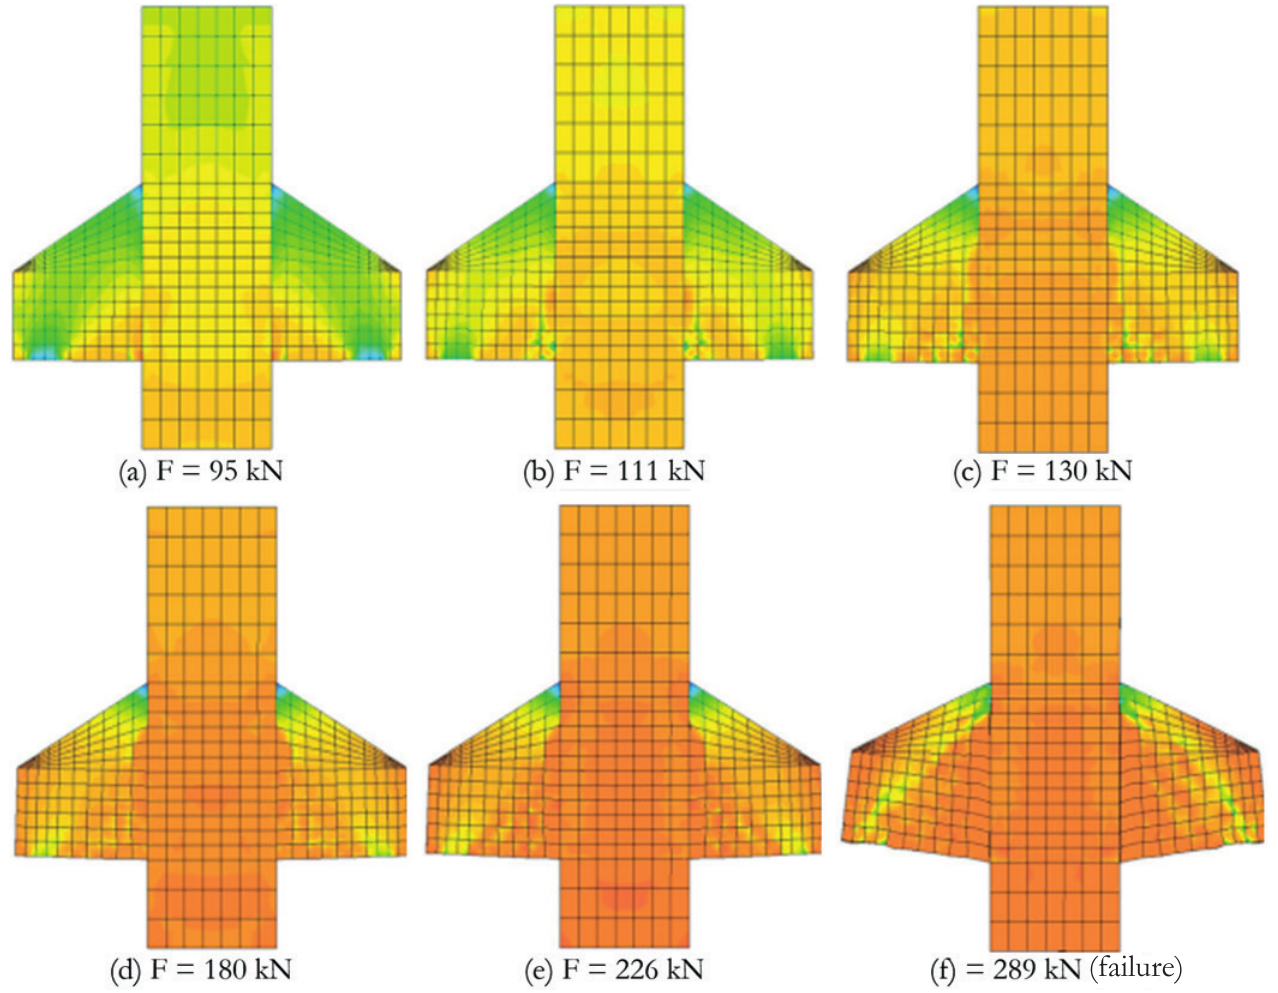
Principal stresses of compression of the computational model (S3) with loading